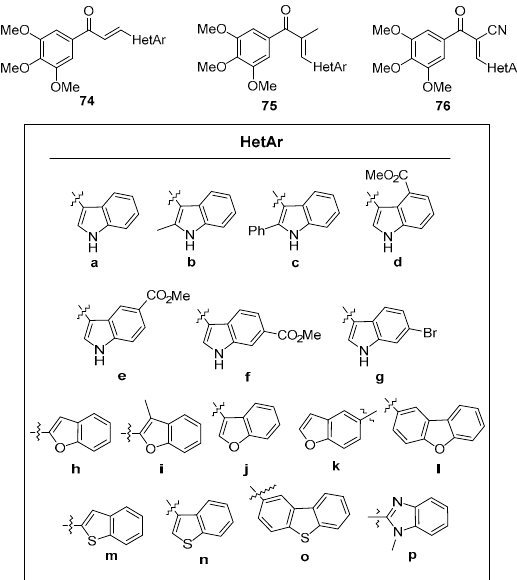
Figure 4. Hybrid chalcone heteroaromatic components prepared by Sun et al. Base-catalyzed C-S condensations that employ green chemistry principles to produce B-ring-substituted hybrid chalcones have also been successfully conducted. See Scheme 31. These processes include the use of benign solvents, solvent-free reactions, microwave irradiation, ultrasound and ball milling. For example, Ashok’s group compared a typical base-catalyzed C-S condensation of 83 and 84 with a solvent-free, microwave-mediated process to prepare a series of carbazolyl hybrid chalcones 85 [58]. The yields for the short-